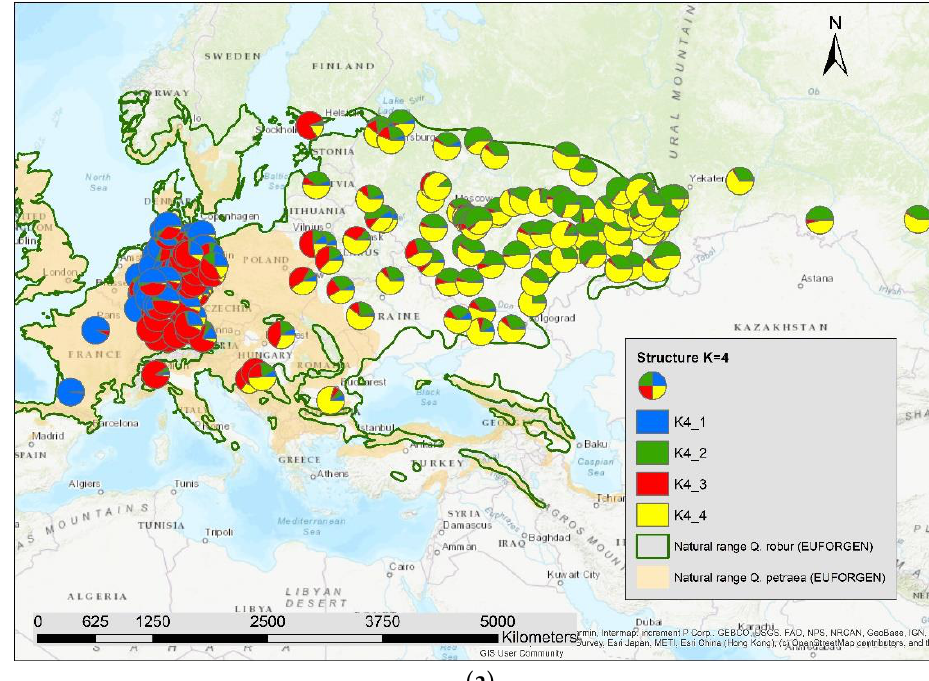
Figure 5. Spatial distribution of the results of STRUCTURE for ( a ) K = 2 and ( b ) K = 3.